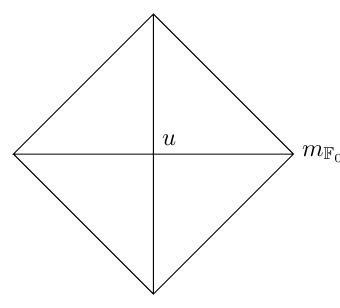
Figure 2: The toric diagram of the local (cid:70)